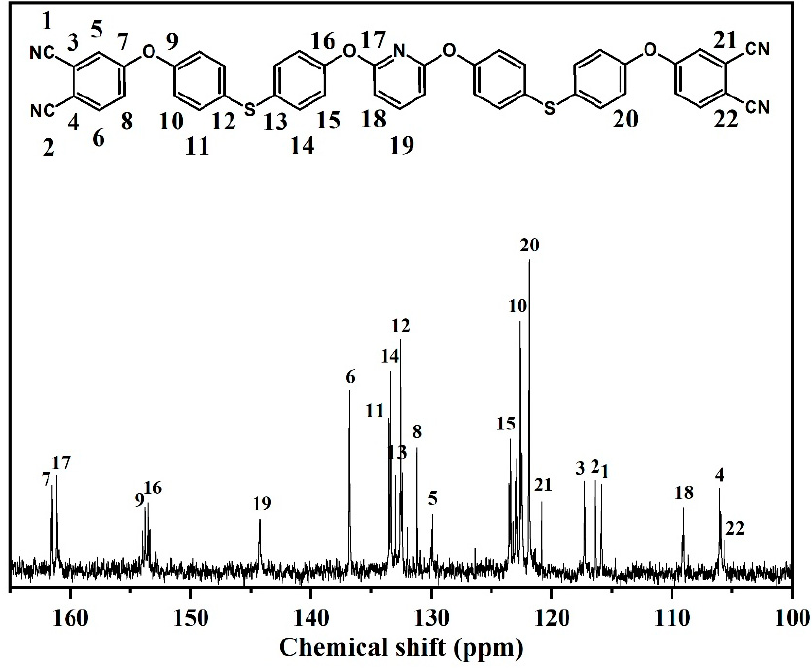
Figure 5. 13 C NMR spectrum of the DPTP monomer.